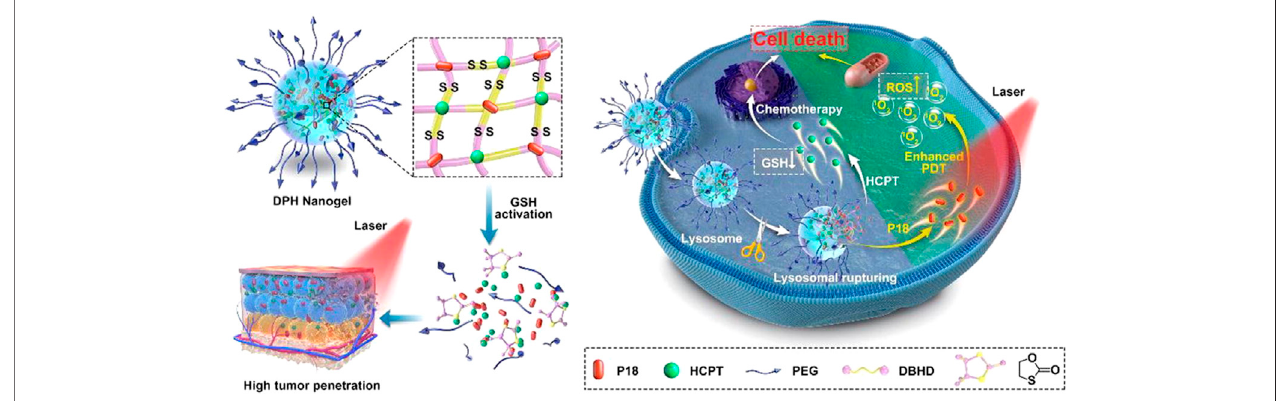
FIGURE 7 | Schematic illustration of redox-responsive prodrug nanogels for combining photodynamic therapy and chemotherapy (Ma et al., 2021). Copyright (2021)